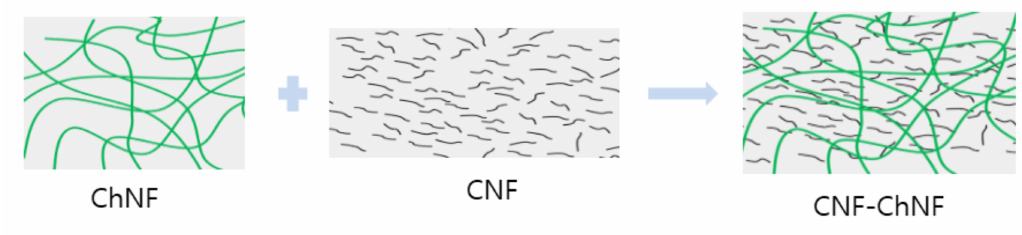
Figure 8. A possible reinforcement mechanism of ChNF and CNF composite.